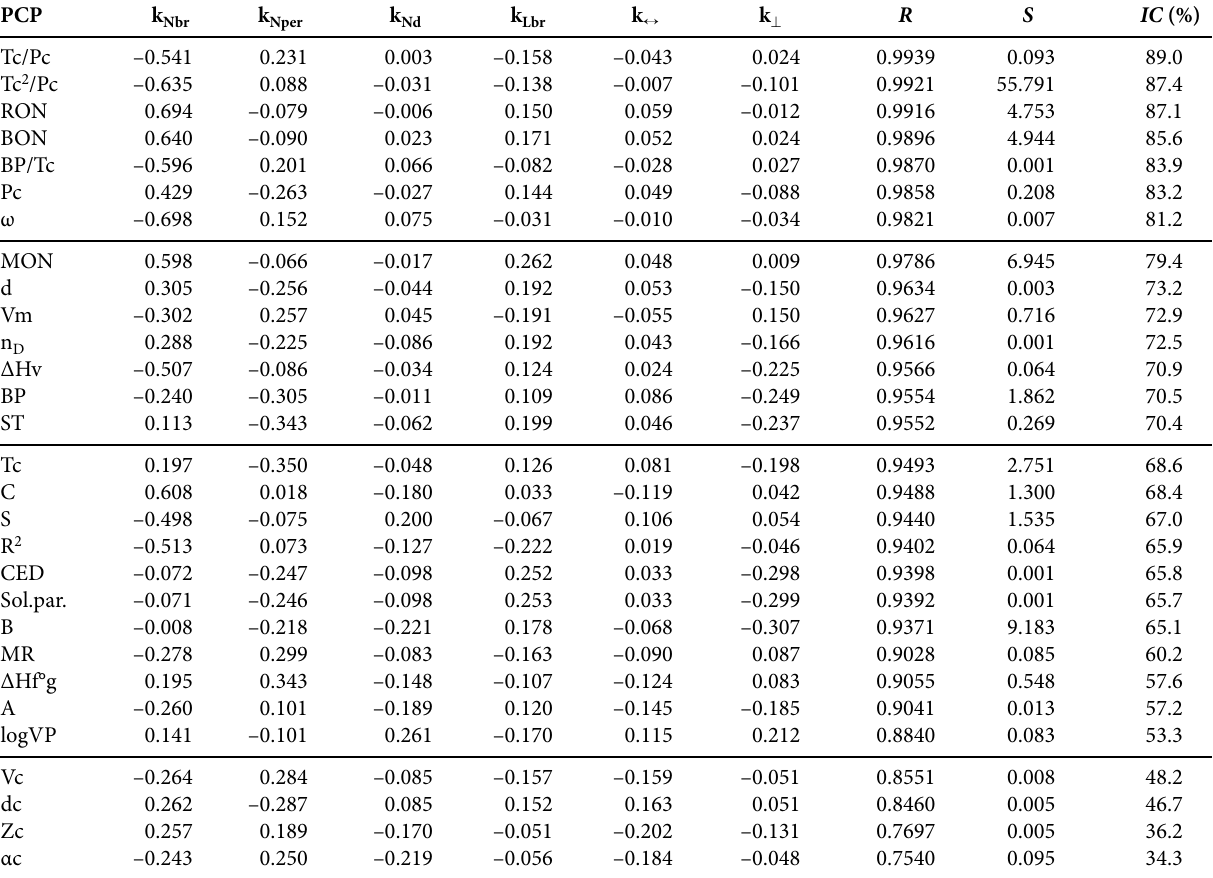
Table 3. Results of the optimization of the correlation between the MOC SN and the values of tested physicochemical properties of octanes sorted by the Information Content regarding branching, 15 IC . PCP k